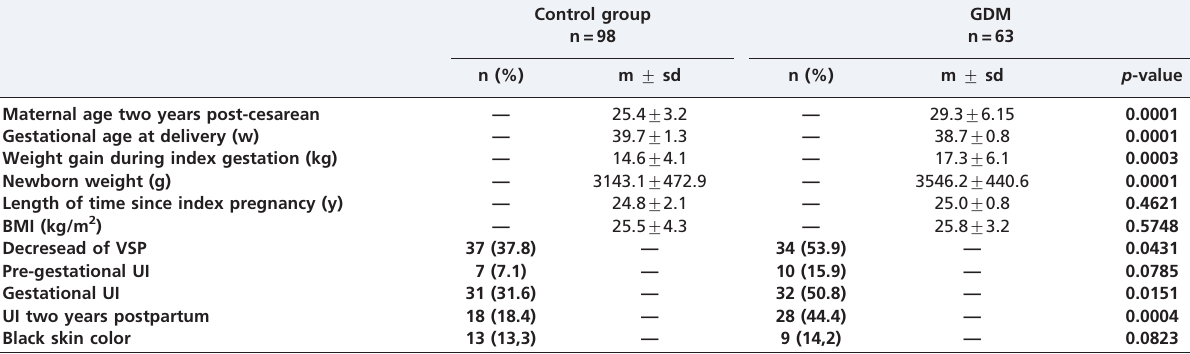
Table 1 - Characteristics of women with and without GDM during their pregnancies and two years post- cesarean